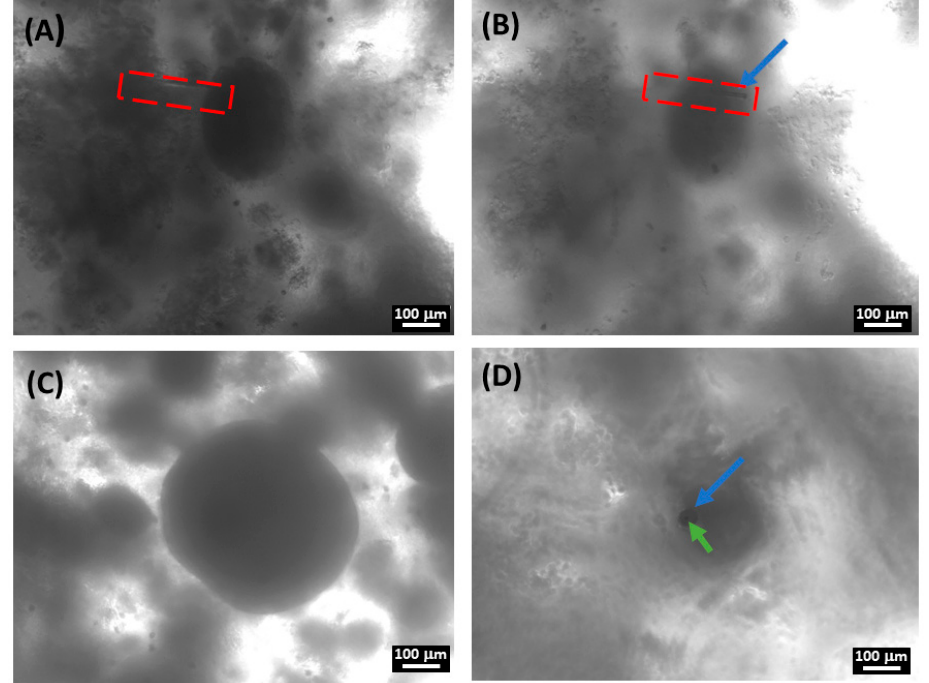
Figure 7. Phase-contrast images during oxygen content SECM measurements inside single spheroids. ( A , B ) Lateral penetration in the side of a spheroid with diameter of ~250 µ m; before ( A ) and after ( B ) penetration. The nanoelectrode tip is indicated in ( B ) with a blue arrow; the optical focus is adjusted to resolve the nanoelectrode tip in the different locations. In ( A , B ) the nanoelectrode profile is contoured with a red dashed line. ( C , D ) Bright field images of vertical penetration inside spheroids with a diameter of ~450 µm; spheroid before ( C ) and after ( D ) penetration. The black dot indicated by the green arrow in ( D ) is the active part of the nanoelectrode; the grey hole indicated by the blue arrow is the upper part seen in perspective. The upper part of the nanoelectrode did not penetrate the spheroid; the optical focus was adjusted to make the nanoelectrode tip visible.